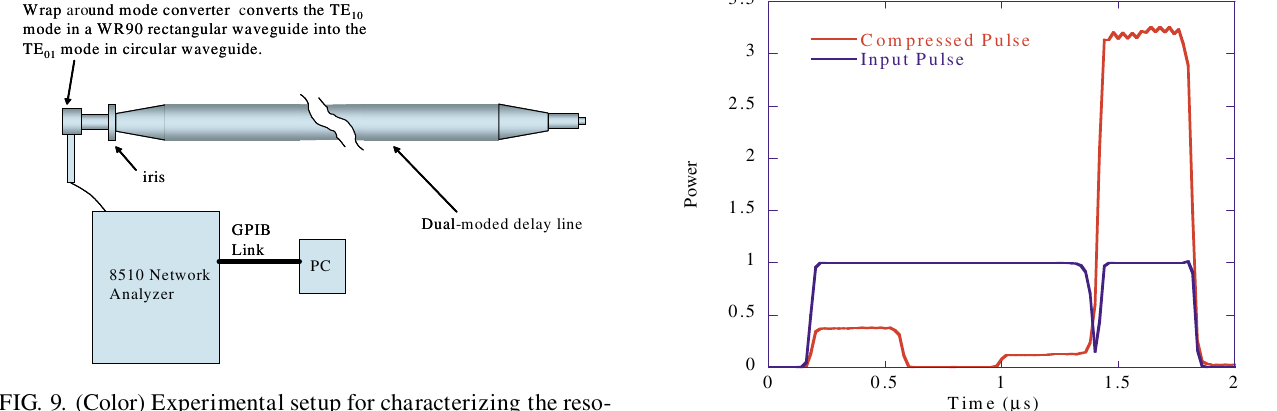
FIG. 9. (Color) Experimental setup for characterizing the reso- nant delay line pulse compression system.